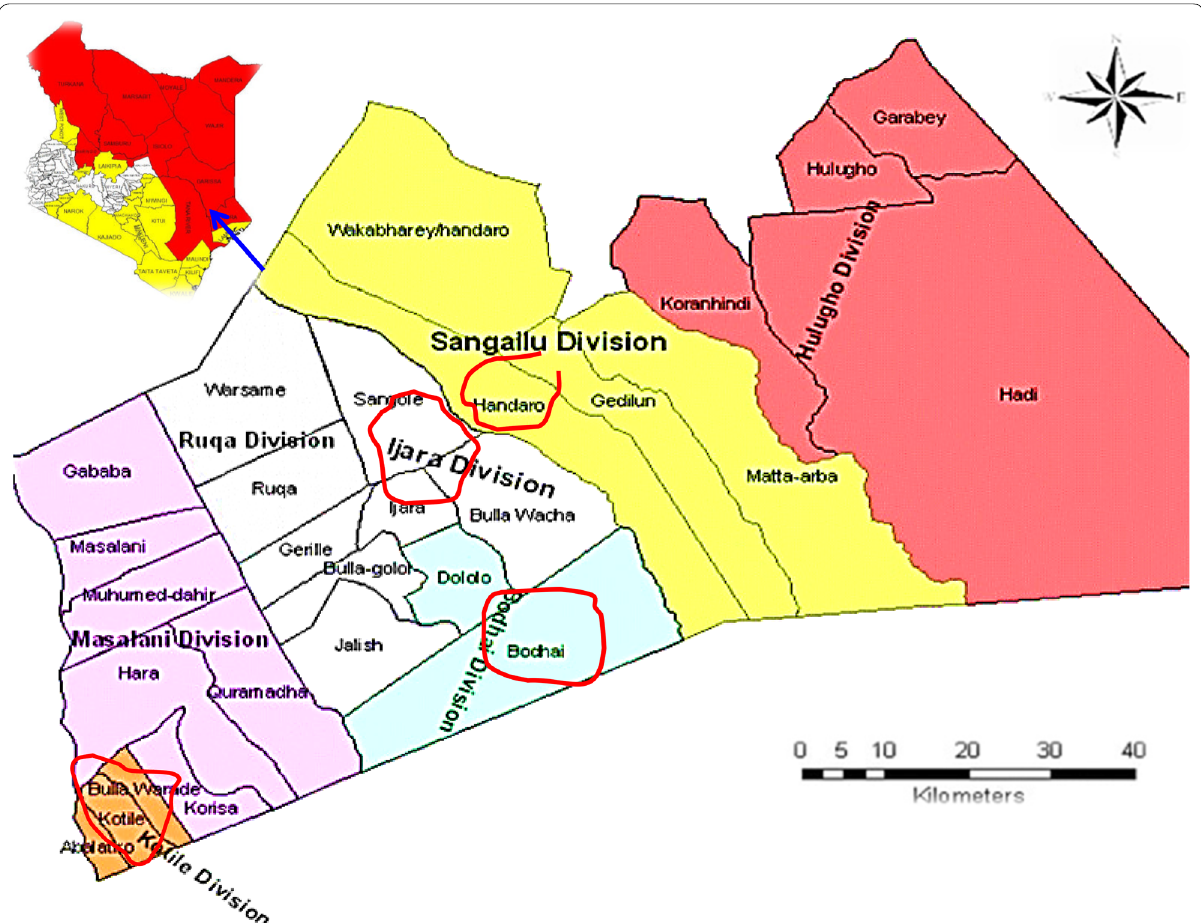
Fig. 1 Kenya Map showing Ijara and study